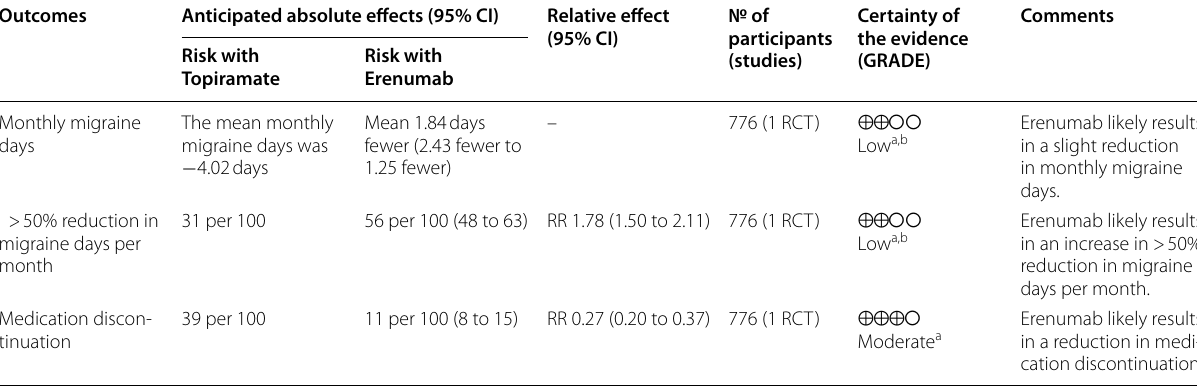
CI confidence interval, RR relative risk